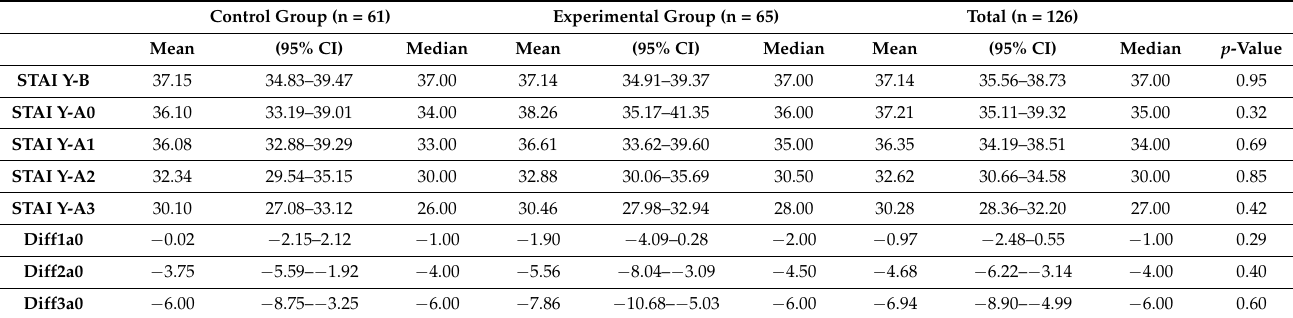
Table 2. Evaluation of Trait Anxiety (STAI Y-B) and State Anxiety (STAI Y-A) scores. STAI Y-A0: baseline score; STAI Y-A1: before first session of radiotherapy; STAI Y-A2: before second session of radiotherapy; STAI Y-A3: at completion of radiotherapy; Diff1a0: difference in mean STAI Y-A scores between baseline and first session of radiotherapy; Diff2a0: difference in mean STAI Y-A scores between baseline time and second session of radiotherapy; Diff3a0: difference in mean STAI Y-A scores between baseline time and completion of